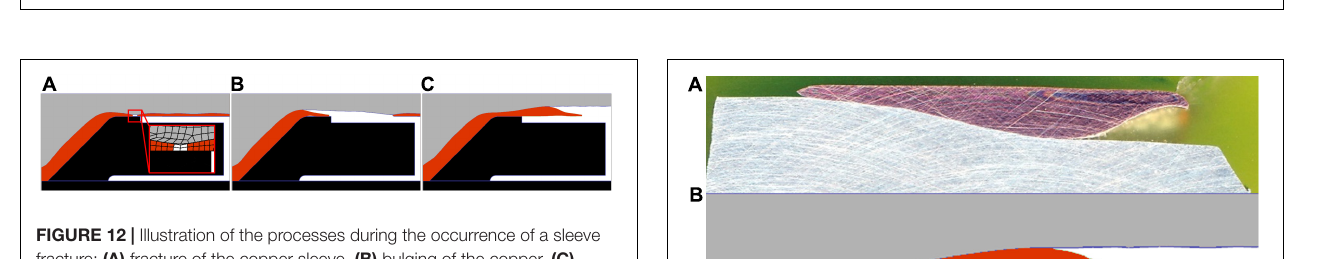
FIGURE 11 | (A–C) Contour plots of strain, velocity and axial stress in extrusion direction; (D–F) courses of strains, velocities and axial stresses in the bearing channel at position P1 and P2.